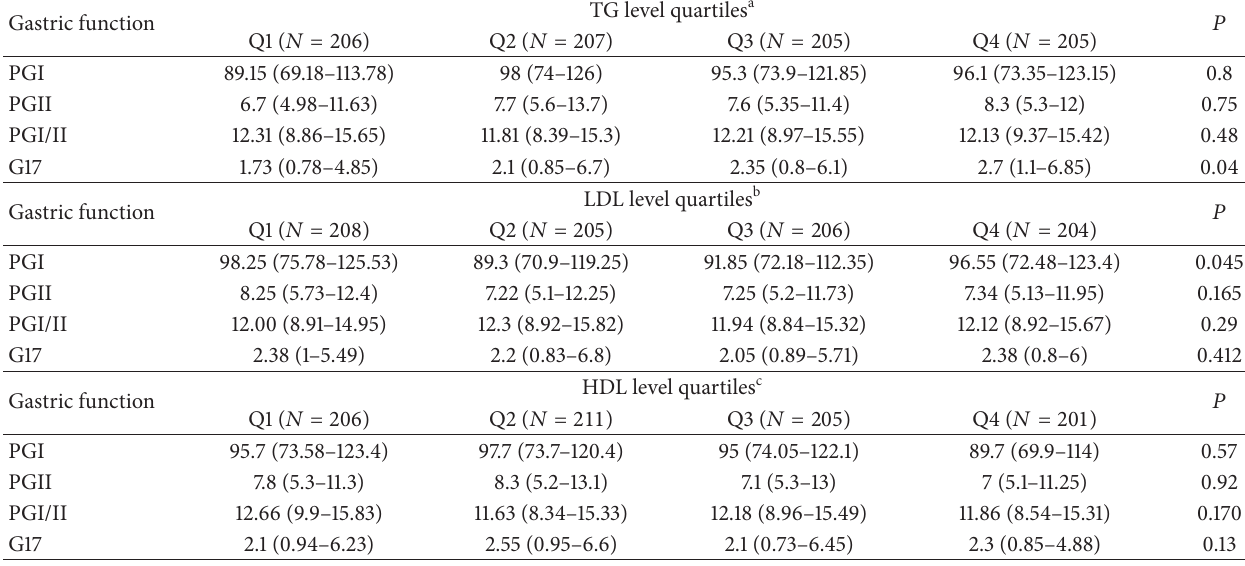
Table 5: The correlation between gastric function parameters and TG, LDL, and HDL levels in serum. Gastric